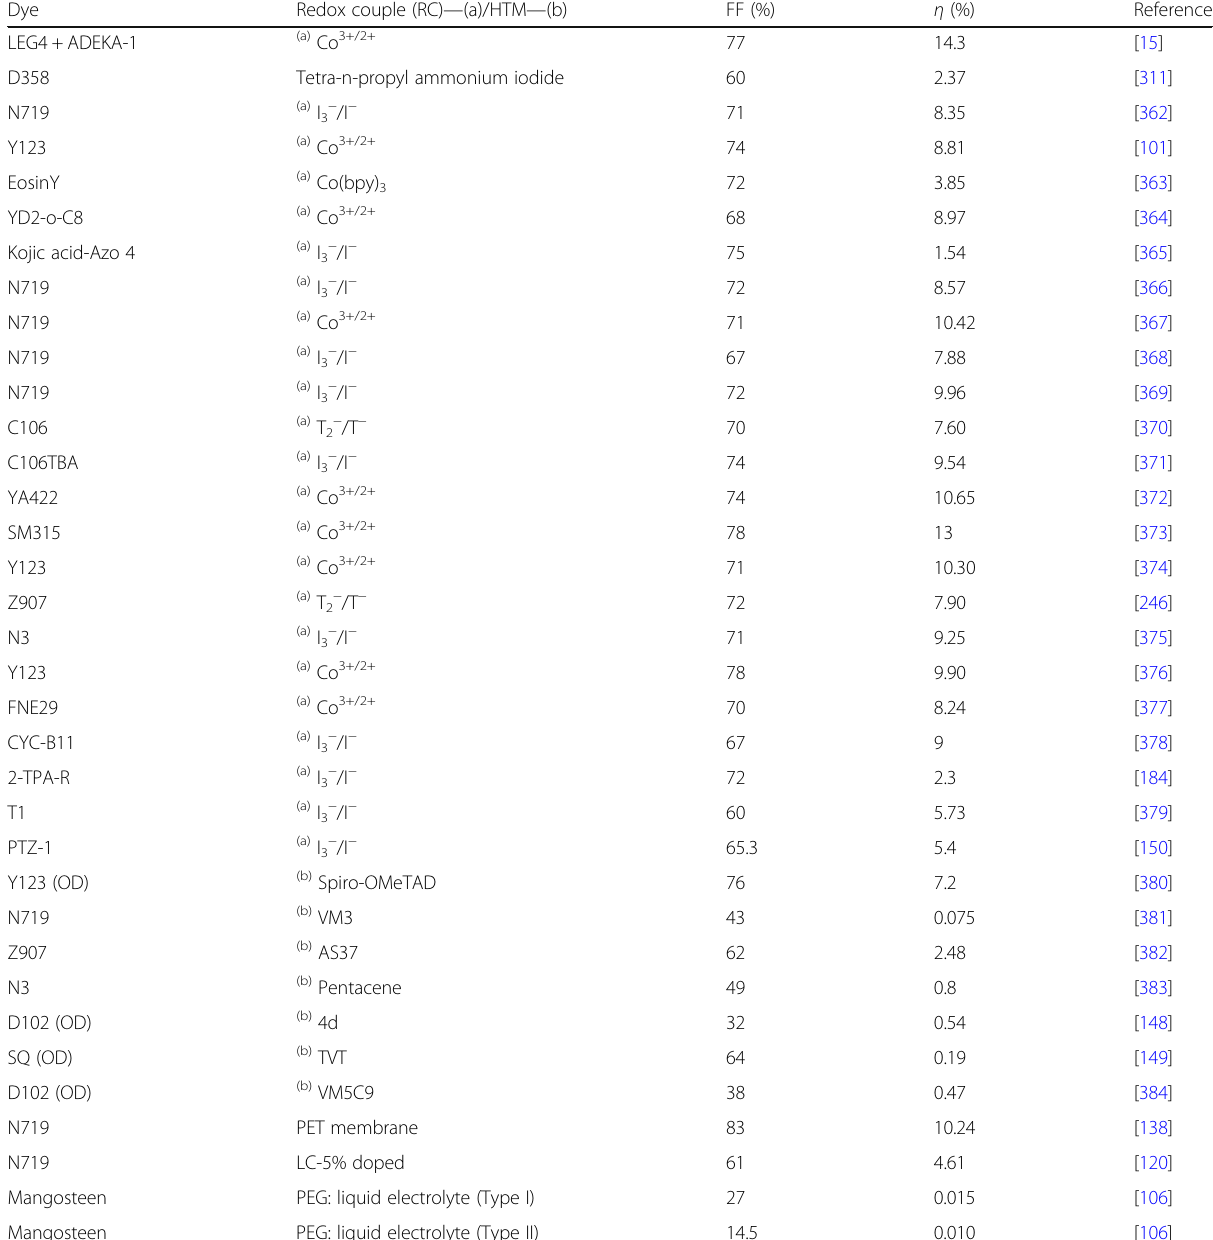
Table 2 Efficiencies for different dyes and